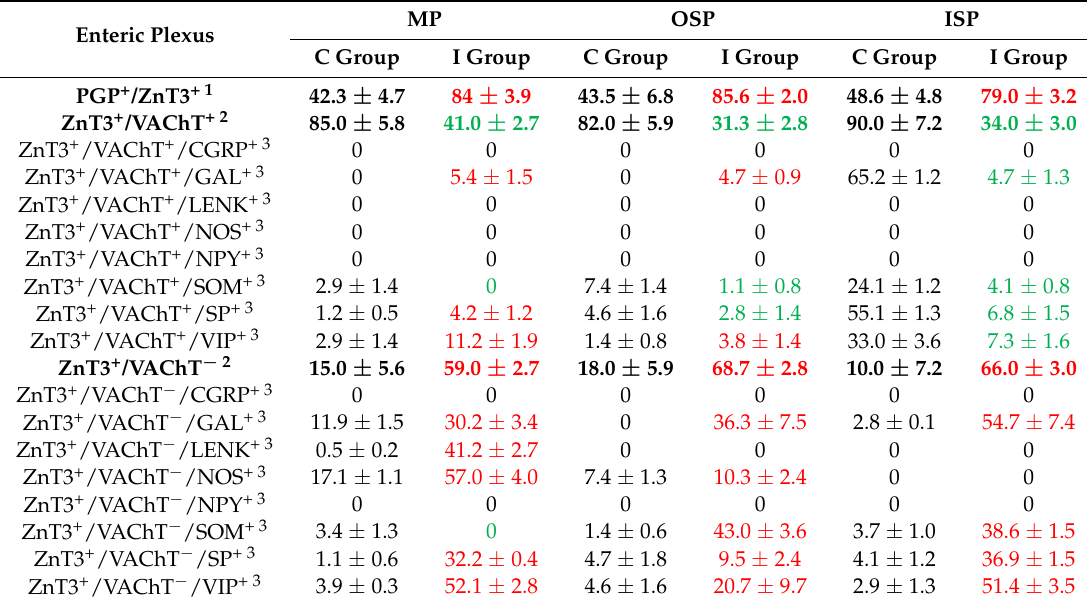
Table 1. Zinc transporter 3-like immunoreactive (ZnT3-LI) neurons in the enteric nervous system (ENS) of the porcine ileum under physiological conditions (C group) and during chemically-induced inflammation (I